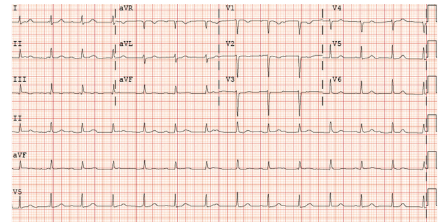
Figure 1: ECG demonstrating complete atrioventricular block with accelerated junctional escape.